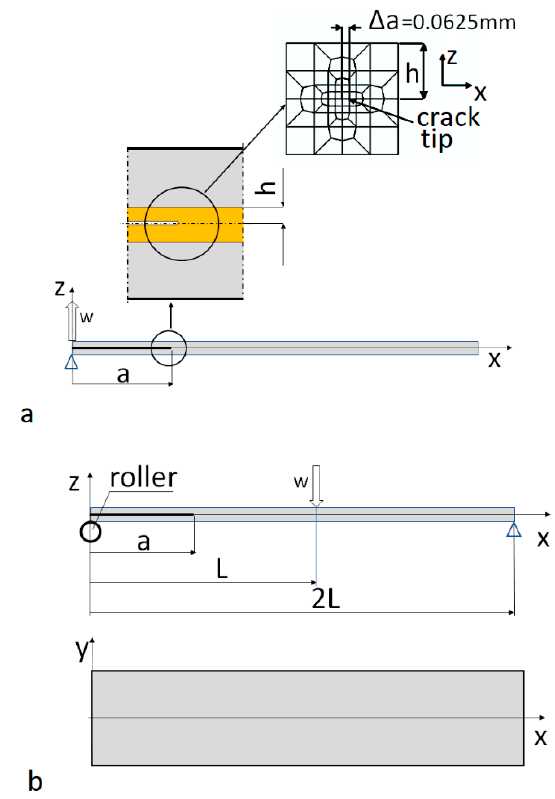
Figure 6. Modeled structures: ( a ) Mode I test; ( b ) Mode II test. Mesh design in the vicinity of the delamination front is shown in the xz plane. It was the same for both models. The h dimension represents the thickness of two reinforcement layers.